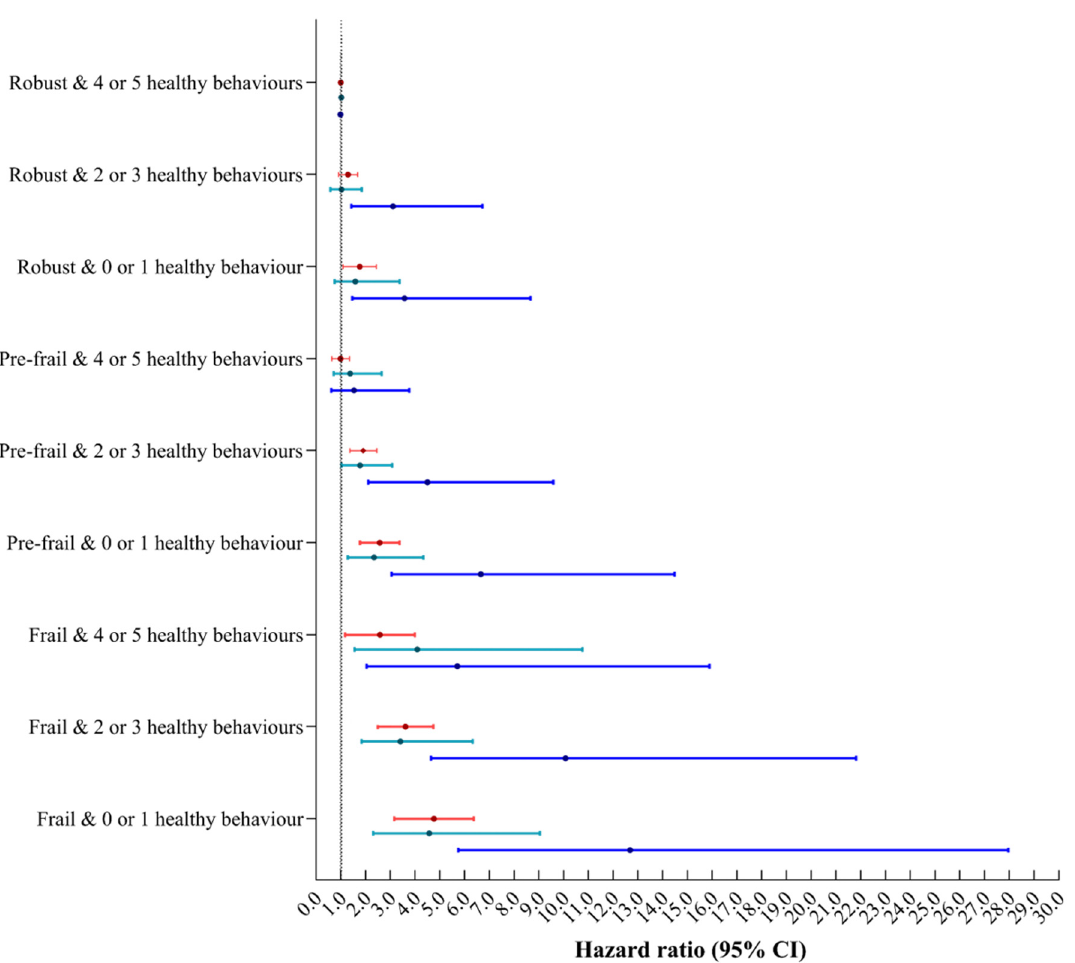
Figure 2. Joint associations of healthy behaviour and frailty with respiratory diseases mortality. Models all adjusted for age, sex, TDI, educational level, race and ethnicity, general health, cancer, diabetes, cardiovascular disease, poor psychological status, family history, sleep duration, coffee intake and consumption of tea. HR = hazard ratio. 95% CI = 95% confidence interval. Red showed total respiratory diseases mortality, green showed influenza and pneumonia mortality, blue showed chronic lower respiratory diseases mortality.